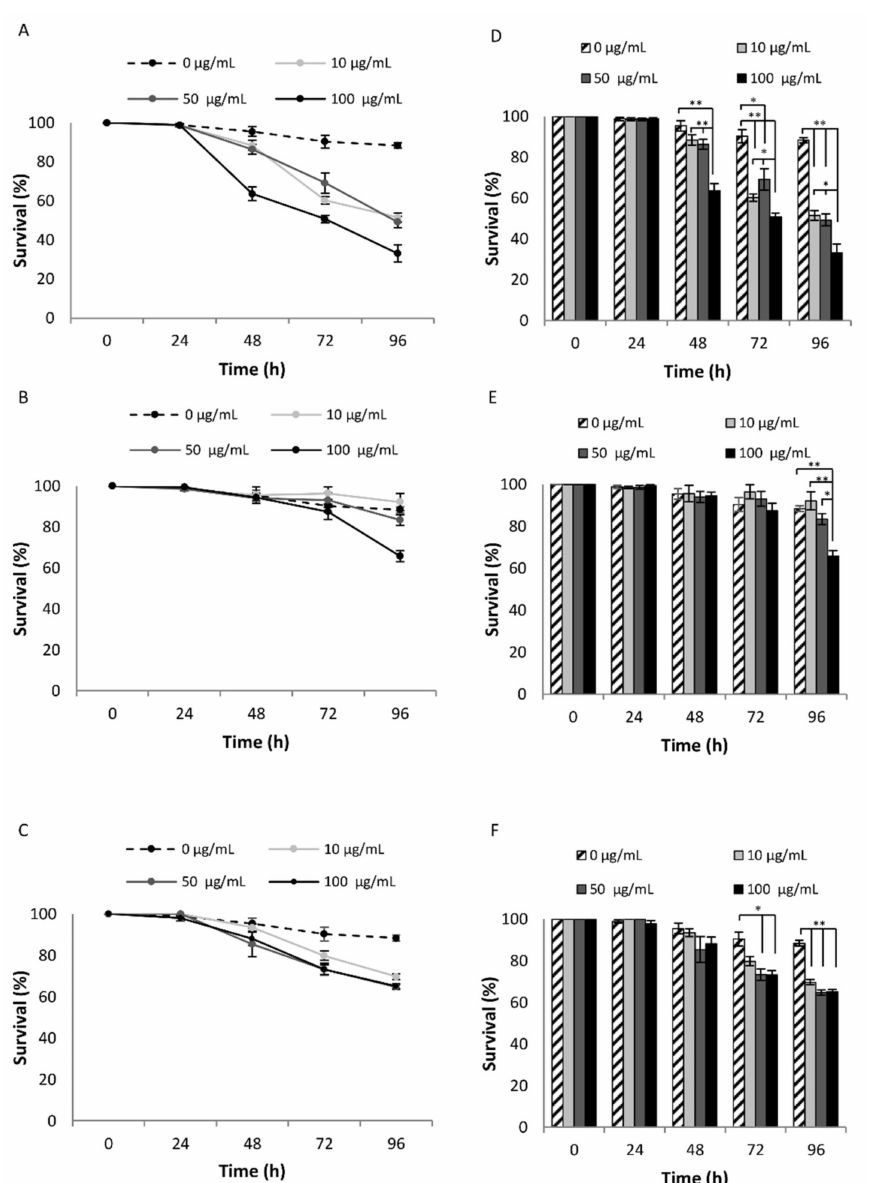
Figure 2. Effect of different NPs concentrations on C. elegans survival. Young adult animals were treated with different concentrations (0, 10, 50 or 100 µ g/mL) of MYTS ( A ), MYTS-EDBE ( B ) and MYTS-PEG ( C ), respectively. Surviving and dead worms were counted at 24, 48, 72 and 96 h of treatment and expressed as percentage with respect to each 0 time. Statistical analysis of MYTS ( D ), MYTS-EDBE ( E ) and MYTS-PEG ( F ) was performed using the Student-T test. Error bars represent standard error and means derive from at least three independent experiments. * p -value < 0.05, ** p -value <